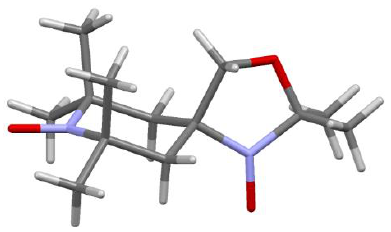
Figure 14. The spatial arrangement of paramagnetic moieties in a diradical molecule 348 of the DOXYL-TEMPO type according to X-ray data [43].